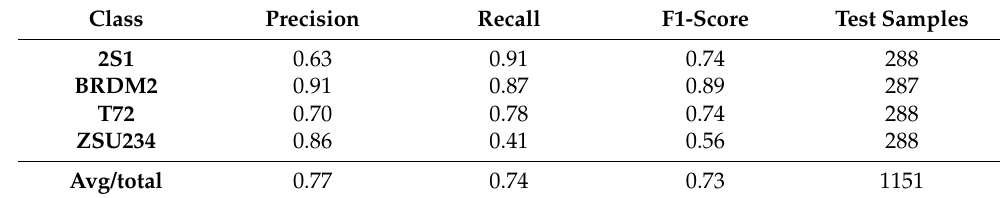
Table 6. Classification results based on CDA and sparse SAR image via 5 samples per